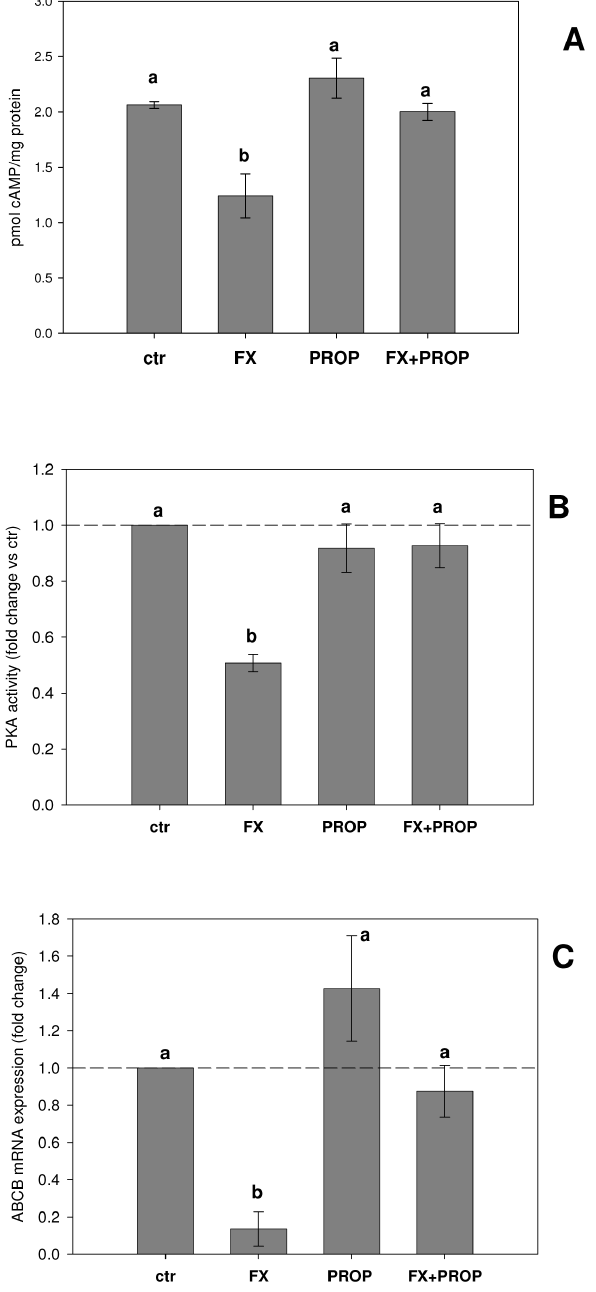
Figure 1. The pharmaceutical FX alters cell signaling endpoints and ABCB mRNA expression in mussel haemocytes under in vivo exposures. (A) cAMP content (B) relative PKA activities (C) relative ABCB mRNA expression. All biological endpoints were assessed in haemocytes collected from mussels exposed for 7 days to 0.3 ng/L FX 0.3 ng/L PROP, or to the mixture FX + PROP (0.3 ng/L + 0.3 ng/L). A